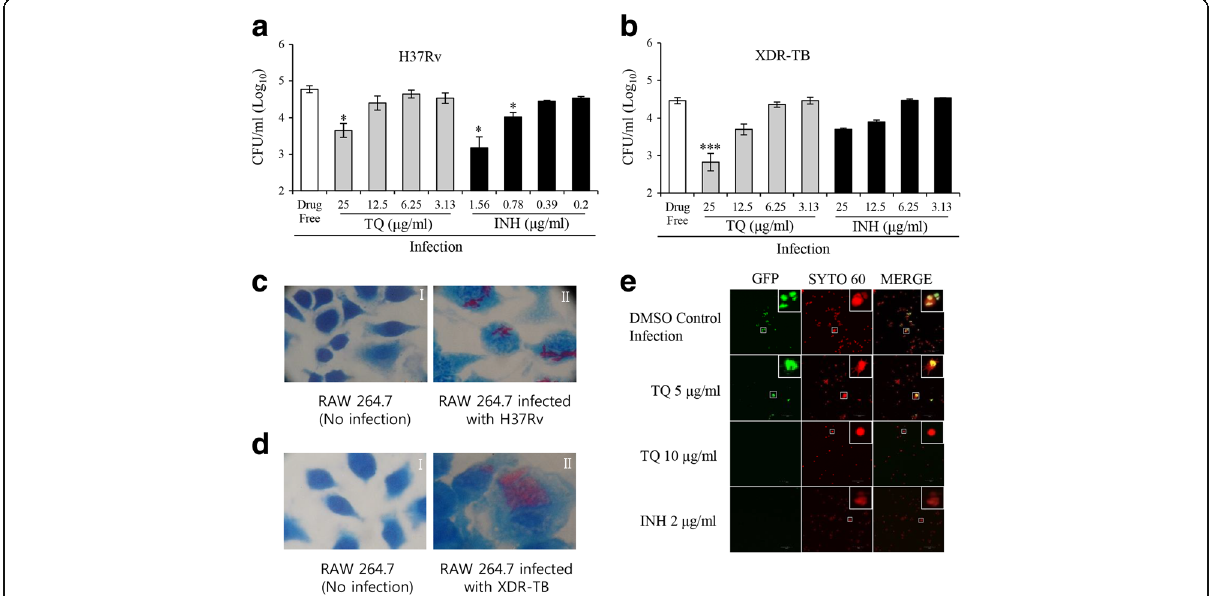
Fig. 1 In vitro efficacy data showing the intracellular killing effect of TQ in M. tuberculosis -infected macrophages. Raw 264.7 macrophages were infected with H37Rv and XDR-TB for 2 h at an MOI of 1:10 at 37 °C with 5% CO 2 followed by drug treatment for 3 days. a H37Rv burden (log 10 CFU) in H37Rv-infected macrophages after TQ and INH treatment. b XDR-TB burden (log 10 CFU) in H37Rv-infected cells after TQ and INH treatment. Data represent the mean ± SD of 3 independent experiments done in triplicate. * P < 0.05 by Student ’ s t-test. In acid-fast staining, methylene blue was used to stain macrophages, while red colored carbol fuchsin stains the bacteria. c - I Uninfected